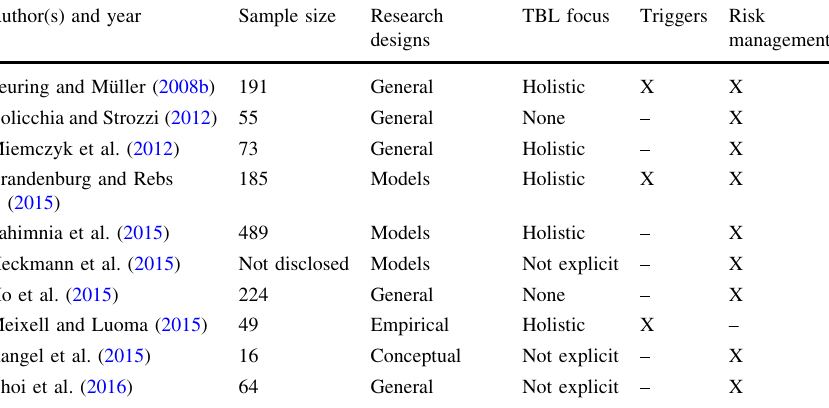
Table 1 Literature reviews on sustainability-oriented stakeholder triggers and risks in